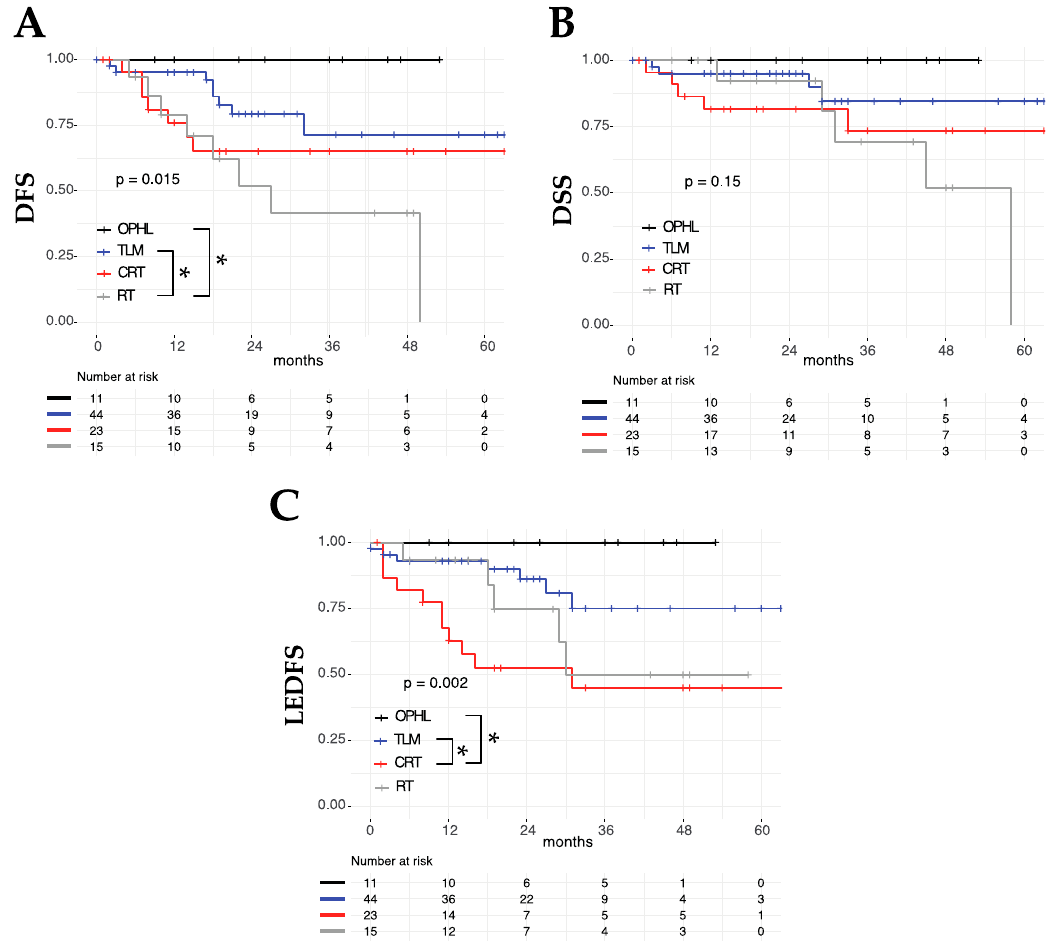
Figure 4. DFS ( A ), DSS ( B ), and LEDFS ( C ) among patients treated by an organ preservation strategy as the first treatment; p values estimated by a log-rank test; * p < 0.05.